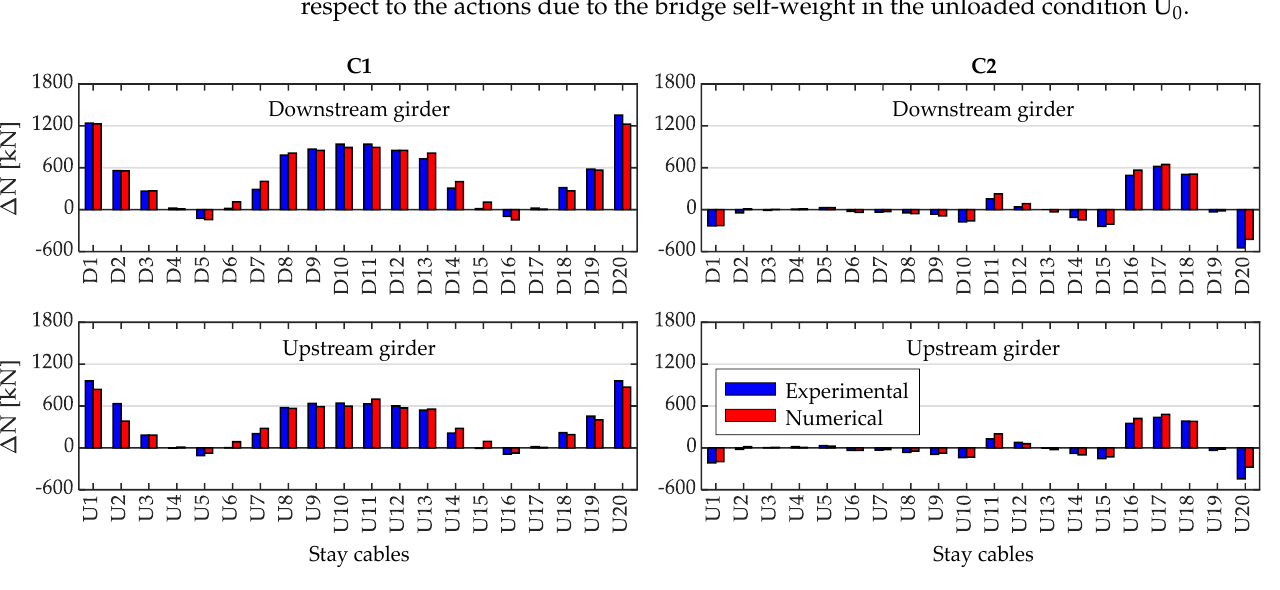
figuration, and comparison with the numerical predictions.